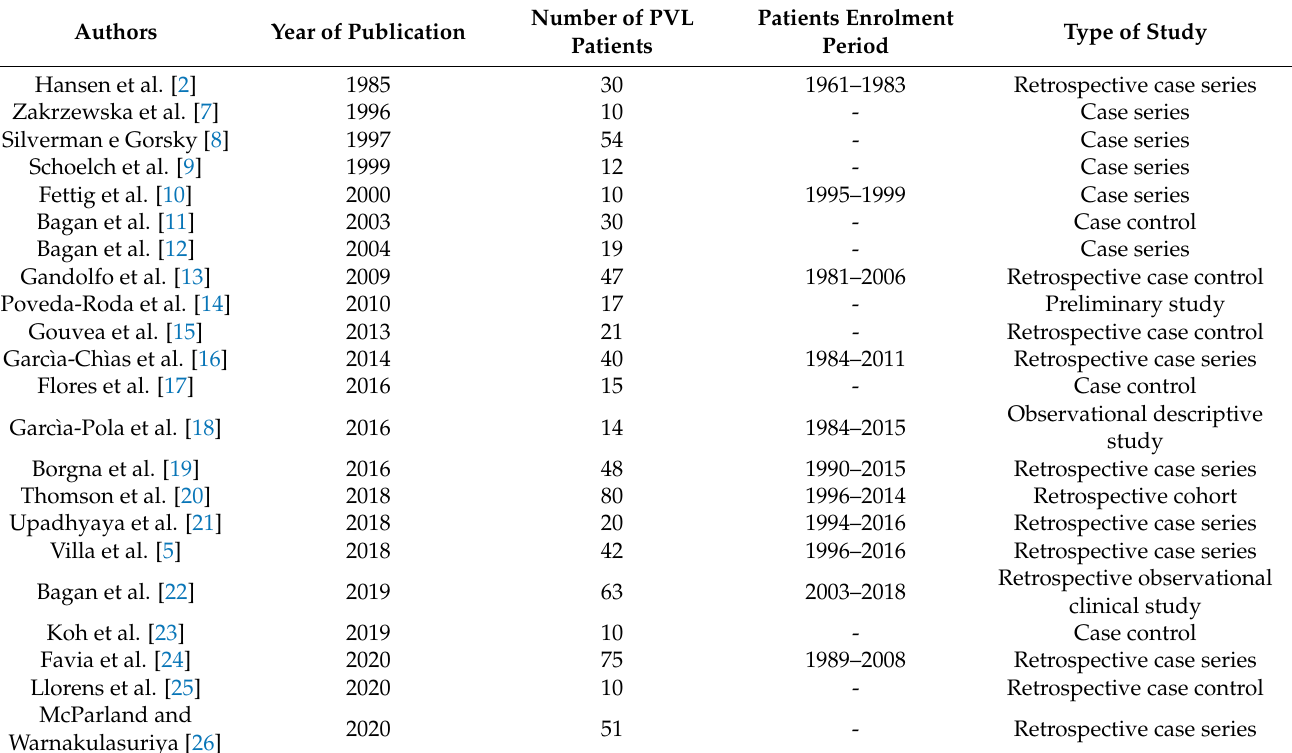
Table 1. Studies included in this systematic